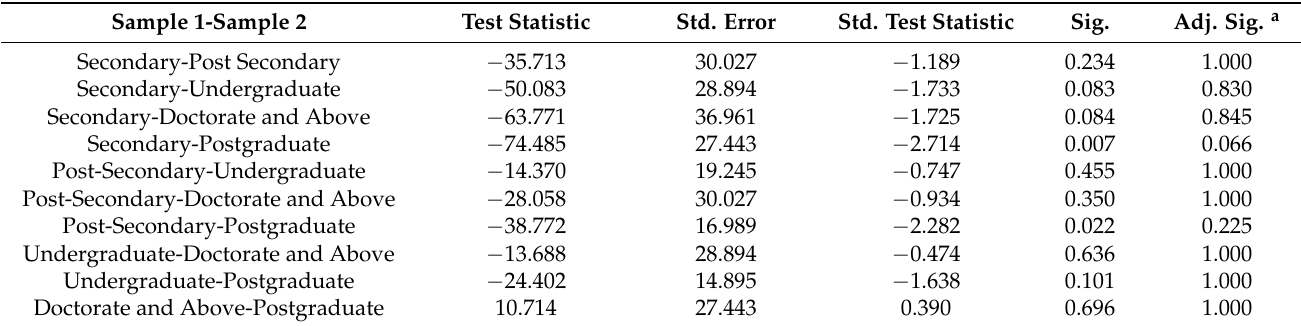
Table 14. Post hoc Analysis—Availability of information.